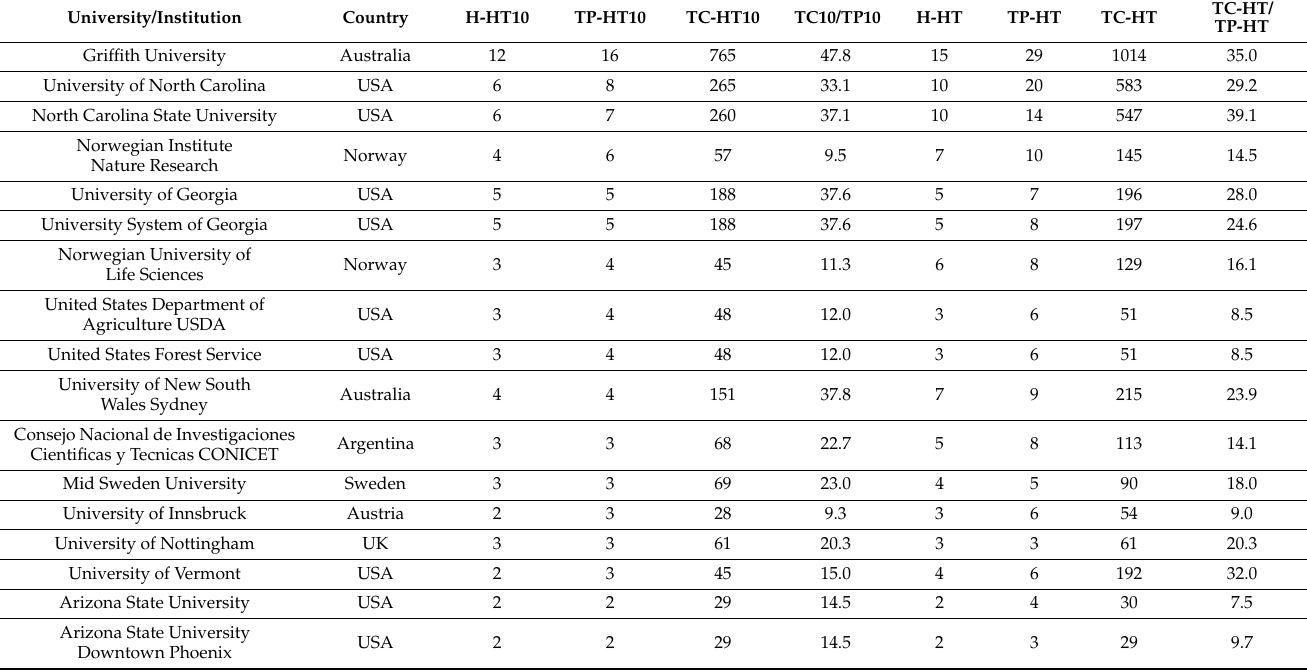
Table 6. The most influential institutions in hiking and trekking.